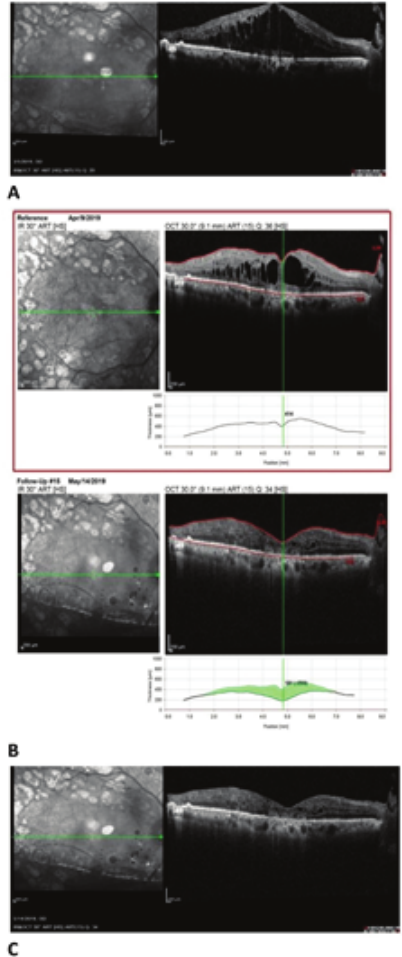
Figure 3. (A) The optical coherence tomography (OCT) depicts a significant diabetic macular edema before starting the topical interferon alpha 2b in the right eye. (B) The upper picture is the OCT at one-month follow-up visit and indicates a significant improvement; however, this improvement is suboptimal. The lower OCT picture shows the acceptable response one month later (two months after the treatment). The diagram shows the thickness changes between the one- and two-month follow-up visits. (C) Shows the stability of the OCT at three-month follow-up visit. In this case, tapering of the drop was started at 12